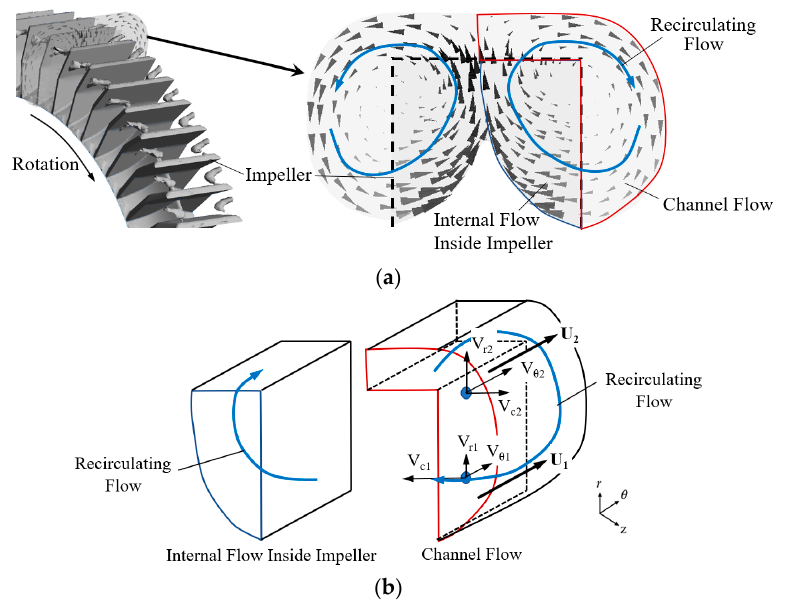
Figure 2. Recirculating flow inside the regenerative impeller: ( a ) velocity vectors [15], ( b ) velocity components.